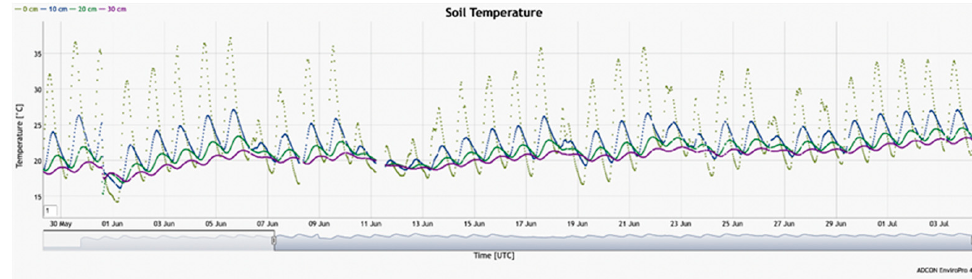
Figure 7. In-depth soil temperature measurements in May and June 2022 in Sadovo,